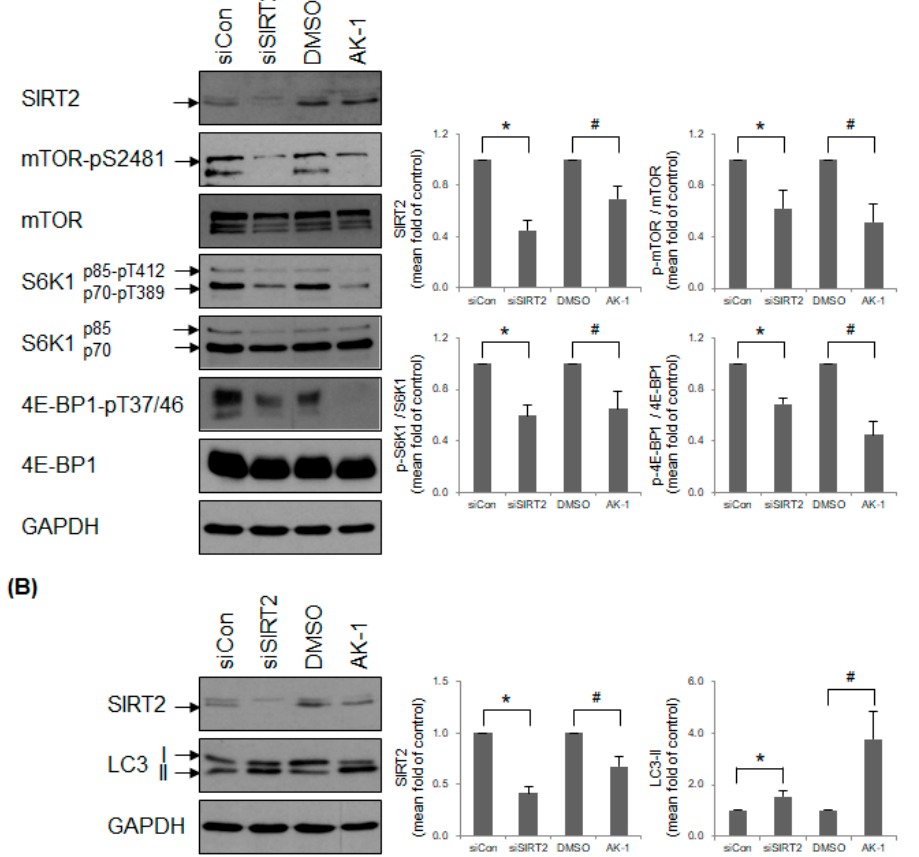
Figure 3. Suppression of SIRT2 inhibits mammalian target of rapamycin (mTOR) signaling. ( A , B